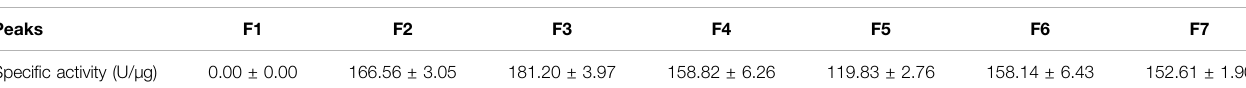
TABLE 1 | The speci fi c activity of fractions corresponding to 7 major chromatographic peaks (mean ± SD, n (cid:1) 3). Peaks F1 F2 F3 F4 F5 F6